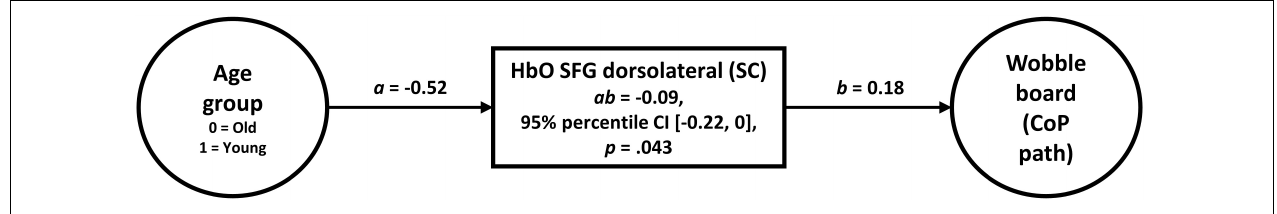
FIGURE 6 | Robust mediation analysis (Zu and Yuan, 2010) revealed that balancing-induced changes in oxygenated hemoglobin (slope coefficient) in the dorsolateral part of the SFG conveys the effect of age on wobble board performance. A Huber-type weight was applied to control 5% of cases ( κ = 0.05), as originally proposed by Zu and Yuan (2010). Note that the influence of sex and Baecke’s sport score was partialed out in the